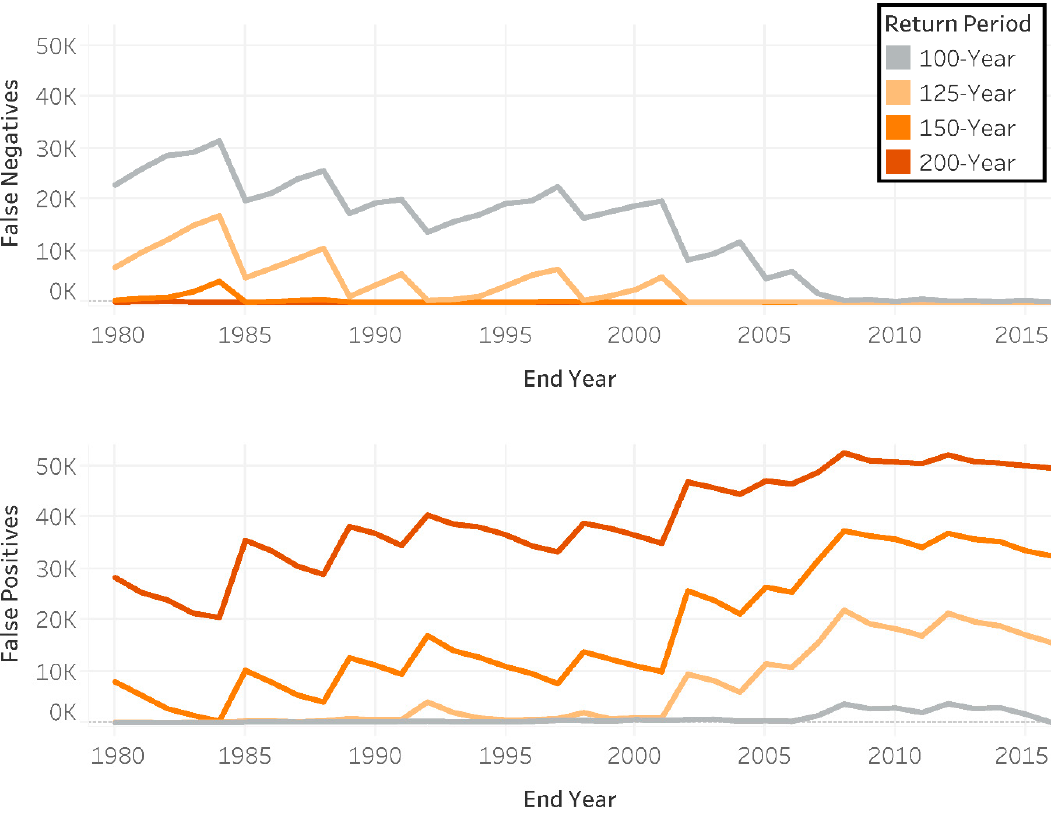
Figure 7. Misclassified population over time by return period relative to the 2016 baseline; false negatives ( top ) and false positives ( bottom ).